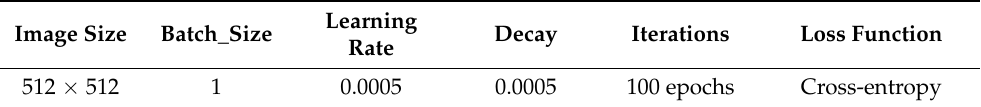
Table 4. Experimental